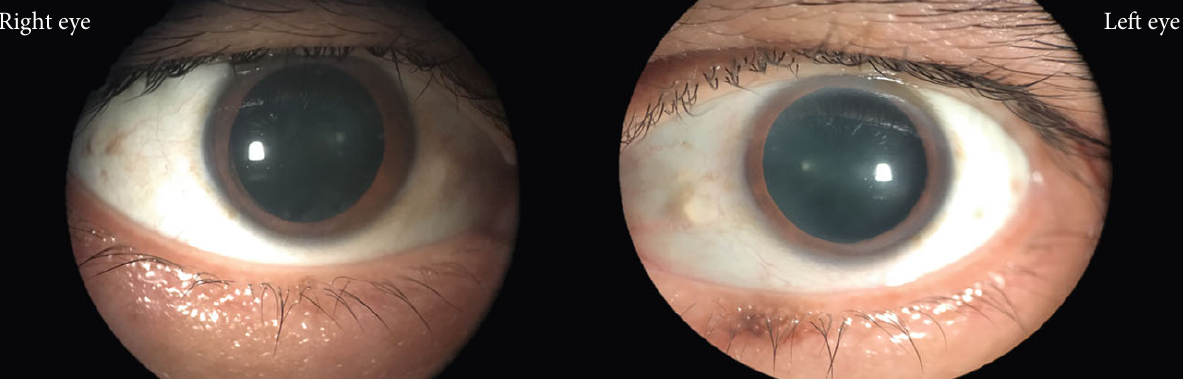
Figure 7: Anterior segment di ff use photography at the end of two years follow-up. Anterior subcapsular opaci fi cation is visible in the photography, which is more prominent in the right eye compared to the